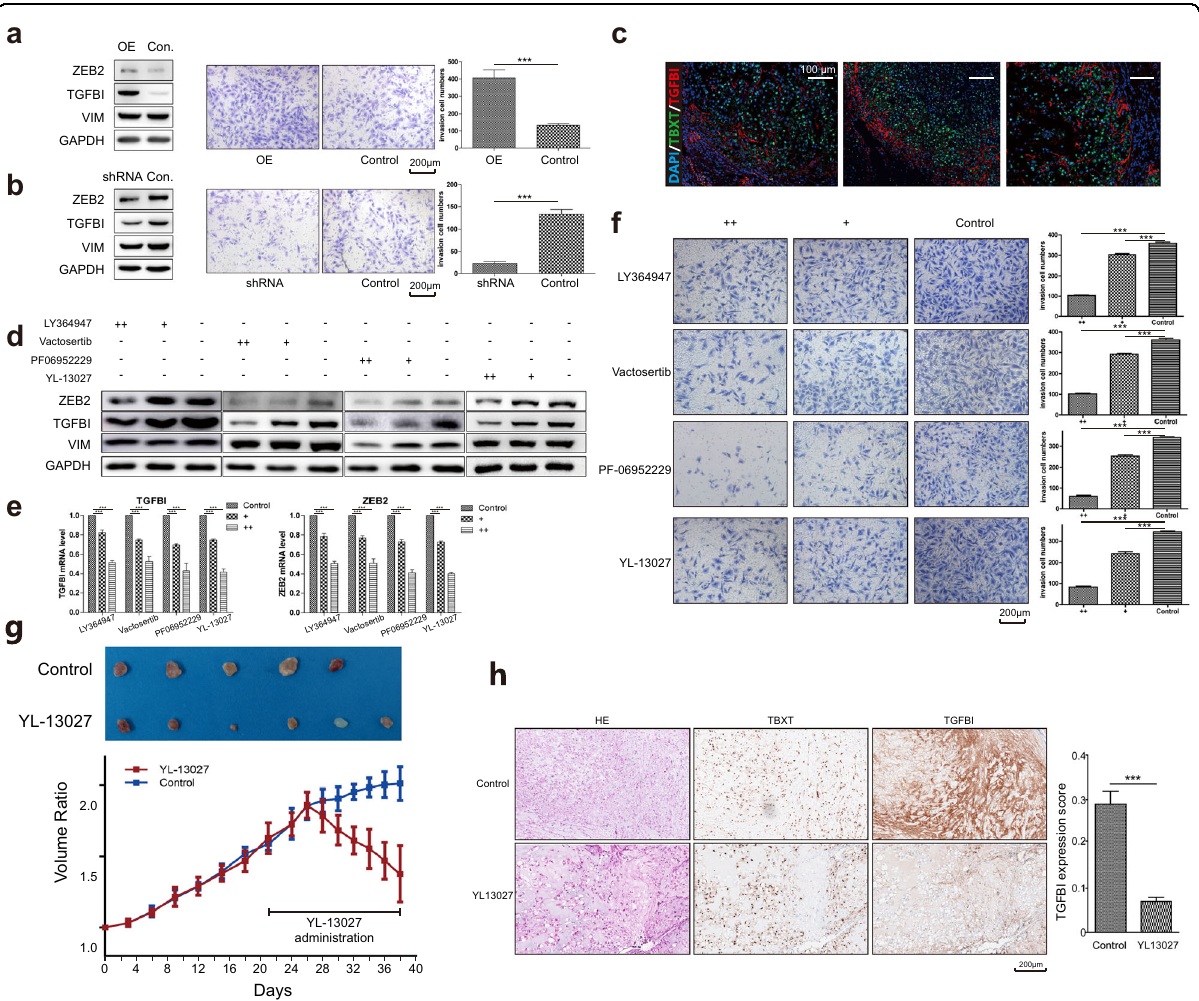
Fig. 5 p-EMT is a novel target to SBC. a , b The construction of stable UM-chor1 cell line with TGFBI overexpression (OE) and knockdown (shRNA). The protein level of TGFBI consists with that of ZEB2. Overexpression of TGFBI increased the invasiveness of the UM-Chor1 through the p-EMT program, and vice versa. The results of quanti fi cation were shown on the right side. Scale bar, 200 μ m. *** P -value ≤ 0.001. c IF images of representative SBC tumors stained for p-EMT markers TGFBI and the malignant cell-speci fi c marker TBXT. Scale bar, 100 μ m. d , e Four TGF- β R1 inhibitors (LY364947, Vactosertib, PF06952229, and YL-13027) repressed the p-EMT-like program, including the decrease of ZEB2 and TGFBI in both protein and mRNA levels. *** P -value ≤ 0.001. f Four TGF- β R1 inhibitors could attenuate the invasiveness of UM-Chor1, suggesting p-EMT as a drug target in vitro. The results of quanti fi cation were shown on the right side. Scale bar, 200 μ m. *** P -value ≤ 0.001; ** P -value ≤ 0.01, * P -value ≤ 0.05. g YL-13027 treatment resulted in a signi fi cant reduction in the growth of UM-Chor1 xenograft. The administration of YL-13027 started on day 21. h The HE and IHC showed TGFBI was signi fi cantly decreased after YL-13027 treatment in vivo. The expression score of TGFBI was calculated by Qupath and was shown on the right side. Scale bar, 200 μ m. *** P -value ≤